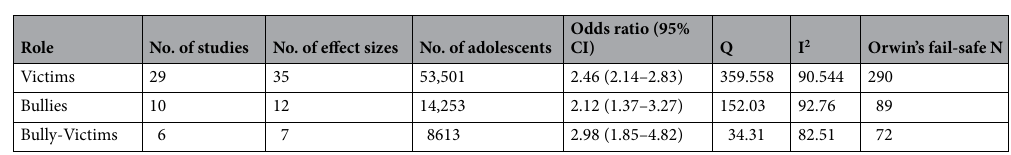
Table 2. Results of the Meta-analyses Between Bullying Roles and